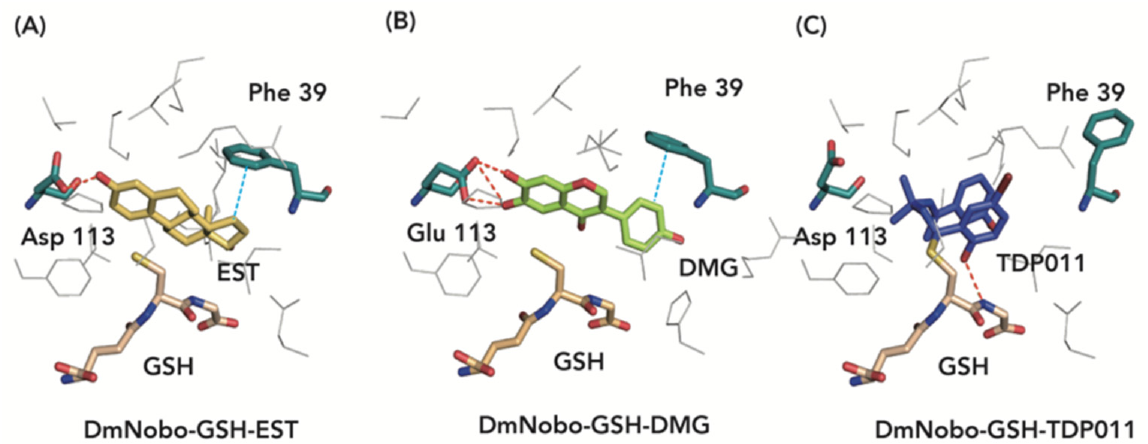
Figure 2. Characteristics of major Nobo inhibitors. Hydrogen bonds are represented by red lines, while hydrophobic interactions are represented by light blue lines. ( A ) EST (carbon atom depicted in yellow) interacts with DmNobo via Asp113 and forms a hydrogen bond. EST forms a hydrophobic interaction with Phe39. ( B ) DMG (carbon atom depicted in green) interacts with AeNobo via Glu113 and forms a hydrogen bond. DMG interacts hydrophobically with Phe39. ( C ) TDP011 (carbon atom depicted in blue) is glutathionylated, but lacks interactions with Asp 113 and Phe39, but it does interact with other hydrophobic amino acids (not shown). Table 1. Characteristics of major Nobo inhibitors.